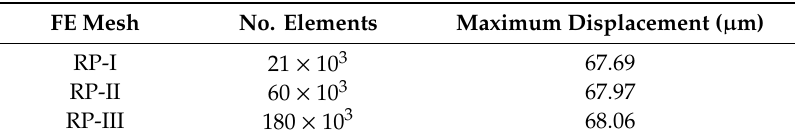
Table 2. Grid dependence results for the mechanical simulations (transmembrane pressure (TMP) = + 0.8 bar, P / H = 10). FE Mesh No.